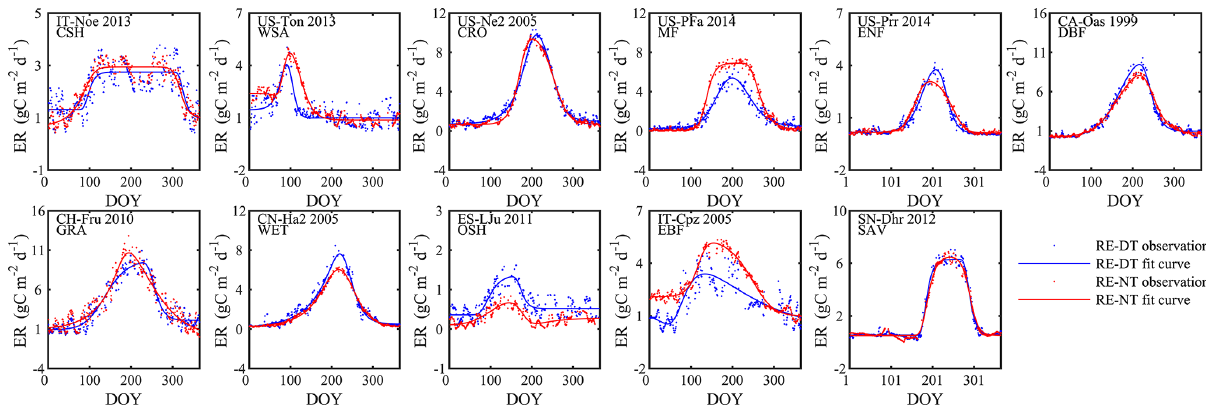
Figure 6. Seasonal dynamics of RE from daytime and nighttime partitioning methods for 11 sites representative of different biomes.